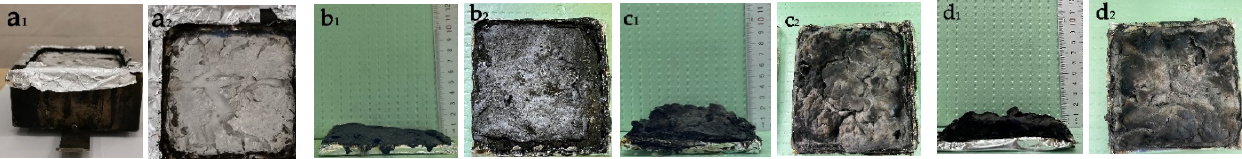
Figure 11. Images of carbon residues of PLA and FPLA composites after CONE tests: ( a 1 ,a 2 ) PLA, ( b 1 ,b 2 ) FPLA-B2, ( c 1 ,c 2 ) FPLA-C32, and ( d 1 ,d 2 ) FPLA-C52.